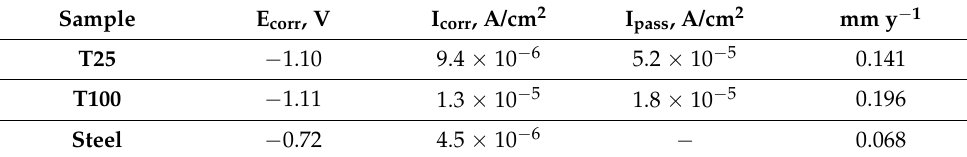
Table 4. Electrochemical parameters according to the PD polarization